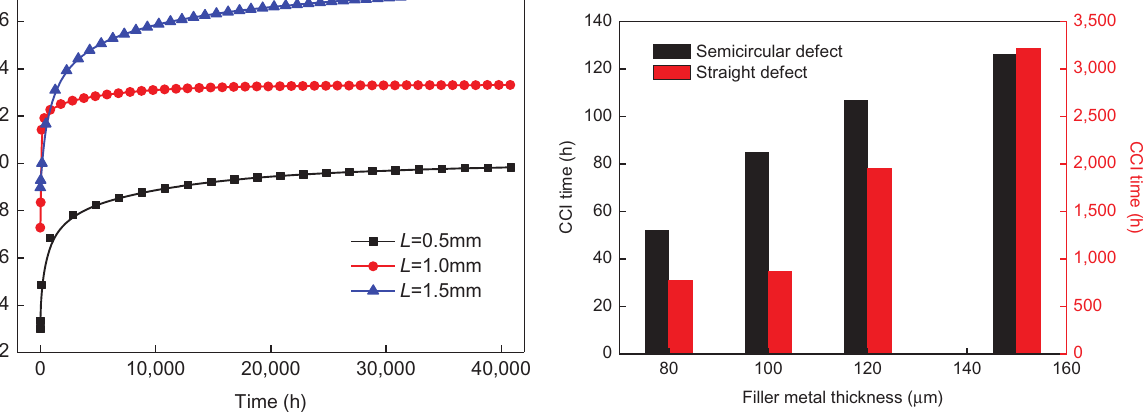
Figure 12: The CEEQ (a) and stress triaxiality (b) variation with time of center point for different defect lengths.